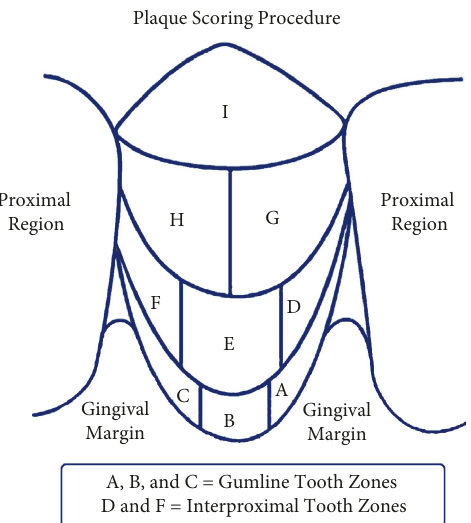
Figure 1: Plaque scoring procedure; A, B, and C; gumline tooth zones, D and F; interproximal tooth